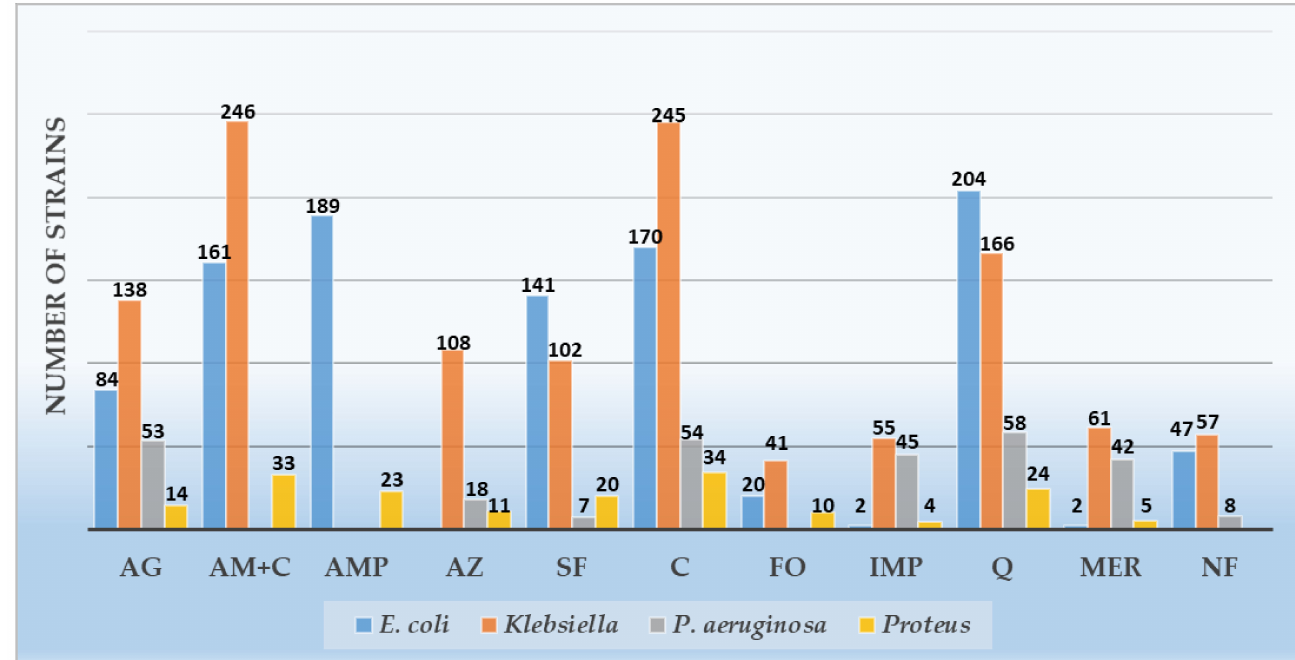
Figure 2. Gram-negative uropathogen resistance profiles (AG—aminoglycosides, AM + C—amoxicillin + clavulanic ac., AMP—ampicillin, AZ—aztreonam, SF—sulfonamides, C—cephalosporins, FO—Fosfomycin, IMP—imipenem, Q— quinolones, MER—meropenem, and